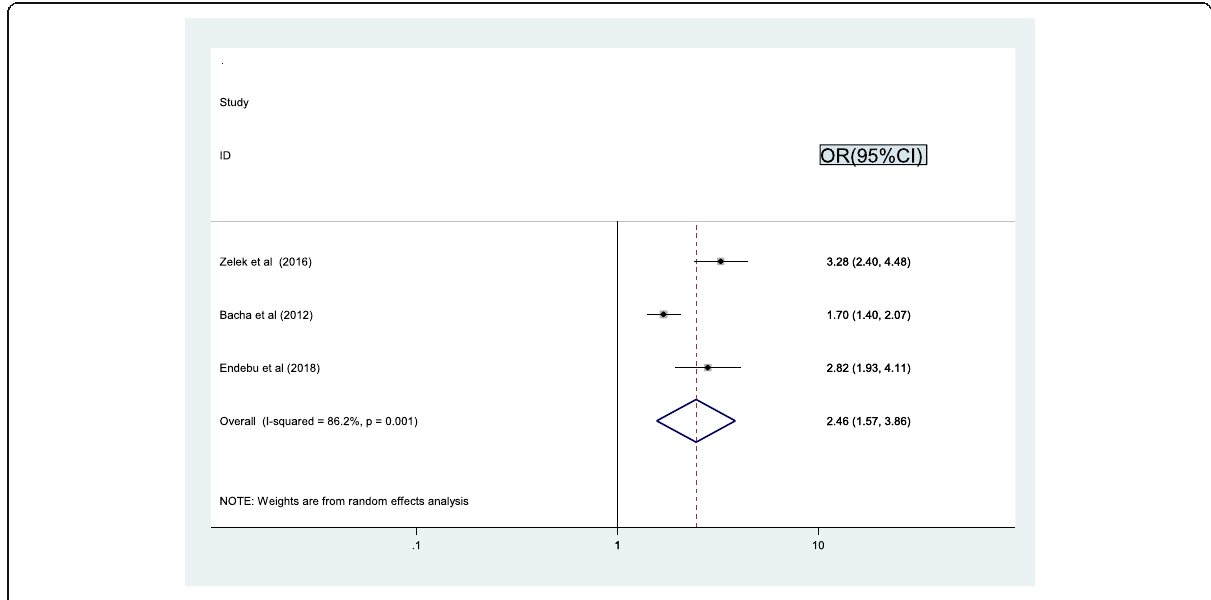
Fig. 6 Pooled odd ratio between regimen change and treatment